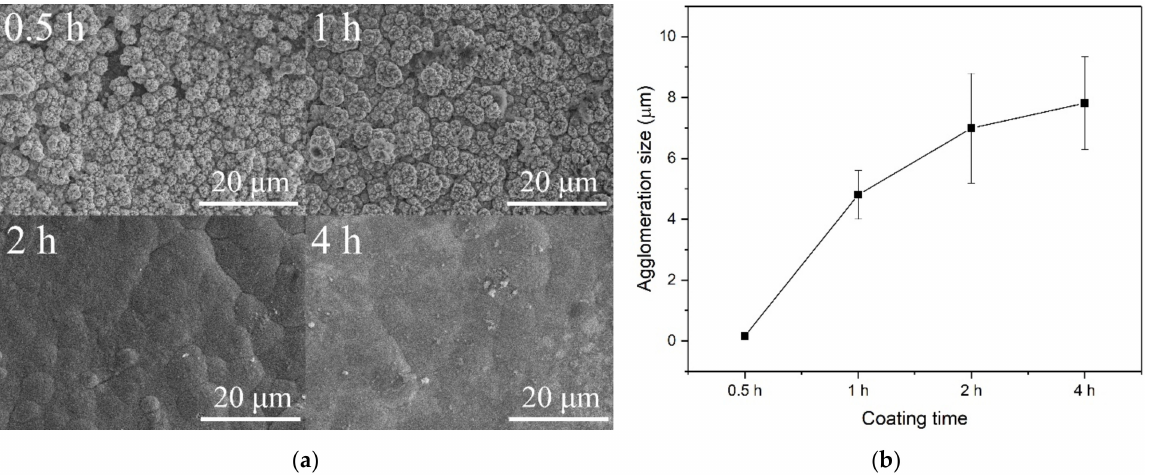
Figure 5. ( a ) The 2k magnification SEM images of the CoFe film with a coating time of 0.5, 1, 2, and 4 h; ( b ) the coating time dependence of average agglomeration size of the CoFe